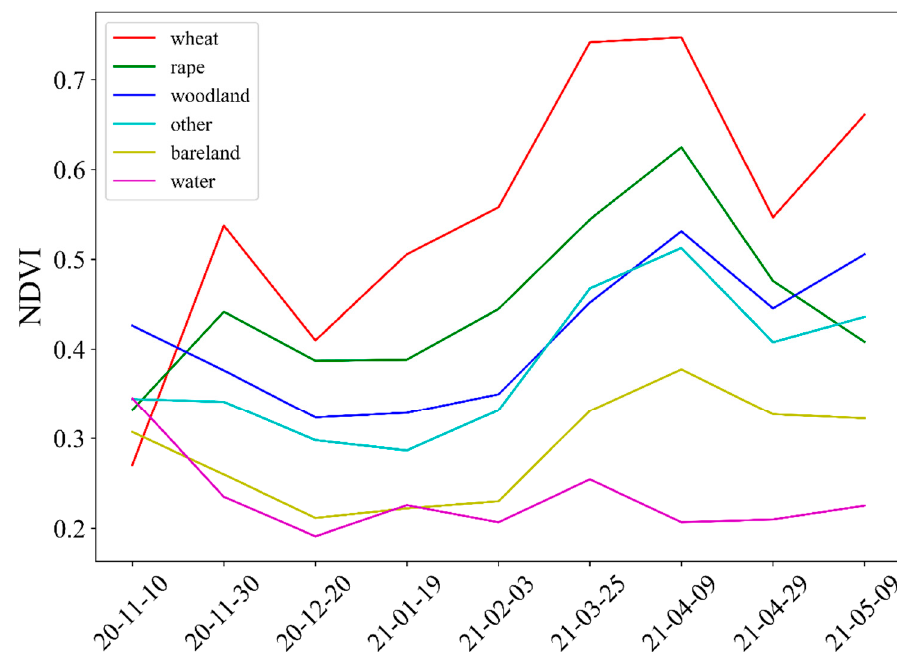
Figure 5. The NDVI time series curves of wheat, rape, woodland, other, bareland and